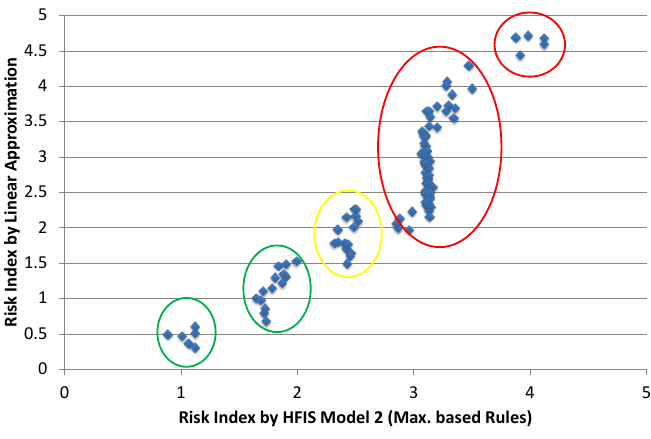
Figure 13. Clustering of locations based on risk index using hybrid